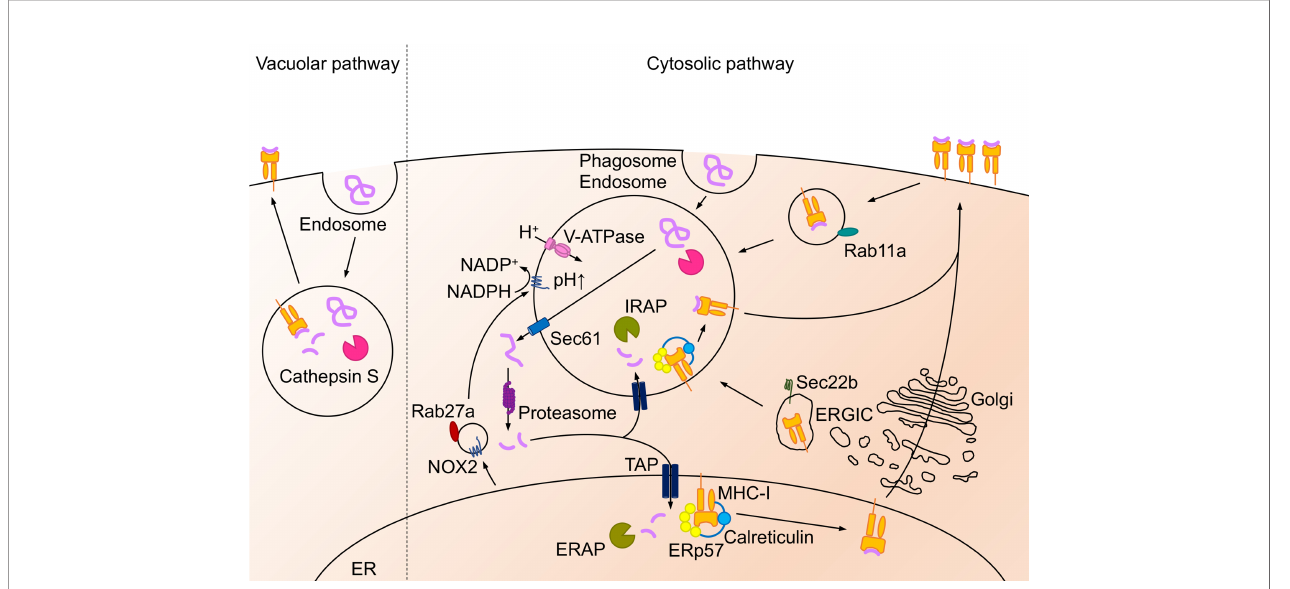
FIGURE 1 | Antigen presentation on MHC-II molecule. Extracellular antigens are endocytosed or phagocytosed, and intracellular antigens are translocated to the late-endosome or the lysosome via autophagosome- or LAMP-2A- mediated autophagy. Then these antigens are degraded by asparaginyl endopeptidase and cathepsin. MHC-II is synthesized in ER and mainly pooled at the plasma membrane as MHC-II-Ii chain complex. When the complex translocates from the ER or the plasma membrane to the acidic compartment, Ii chain is degraded into CLIP and driven out by interaction with H2-M. Afterward, antigen peptides bind to the MHC-II and the peptide-MHC-II complex exports to the cell